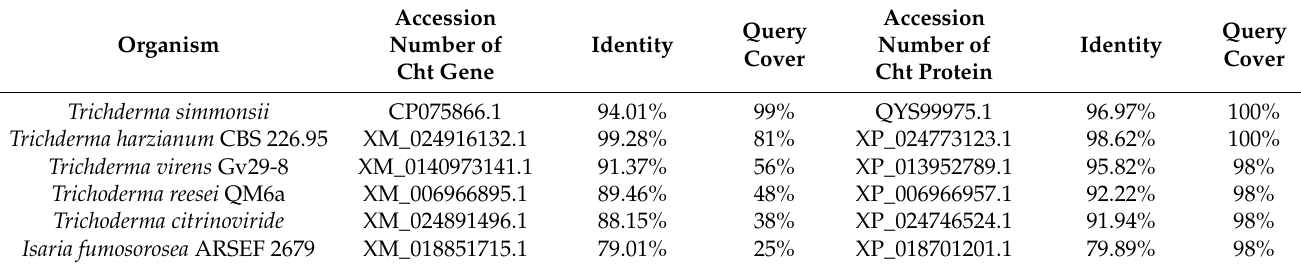
Table 3. The cyanide hydratase gene and protein alignment in BLAST and its identity with other homologous sequences.